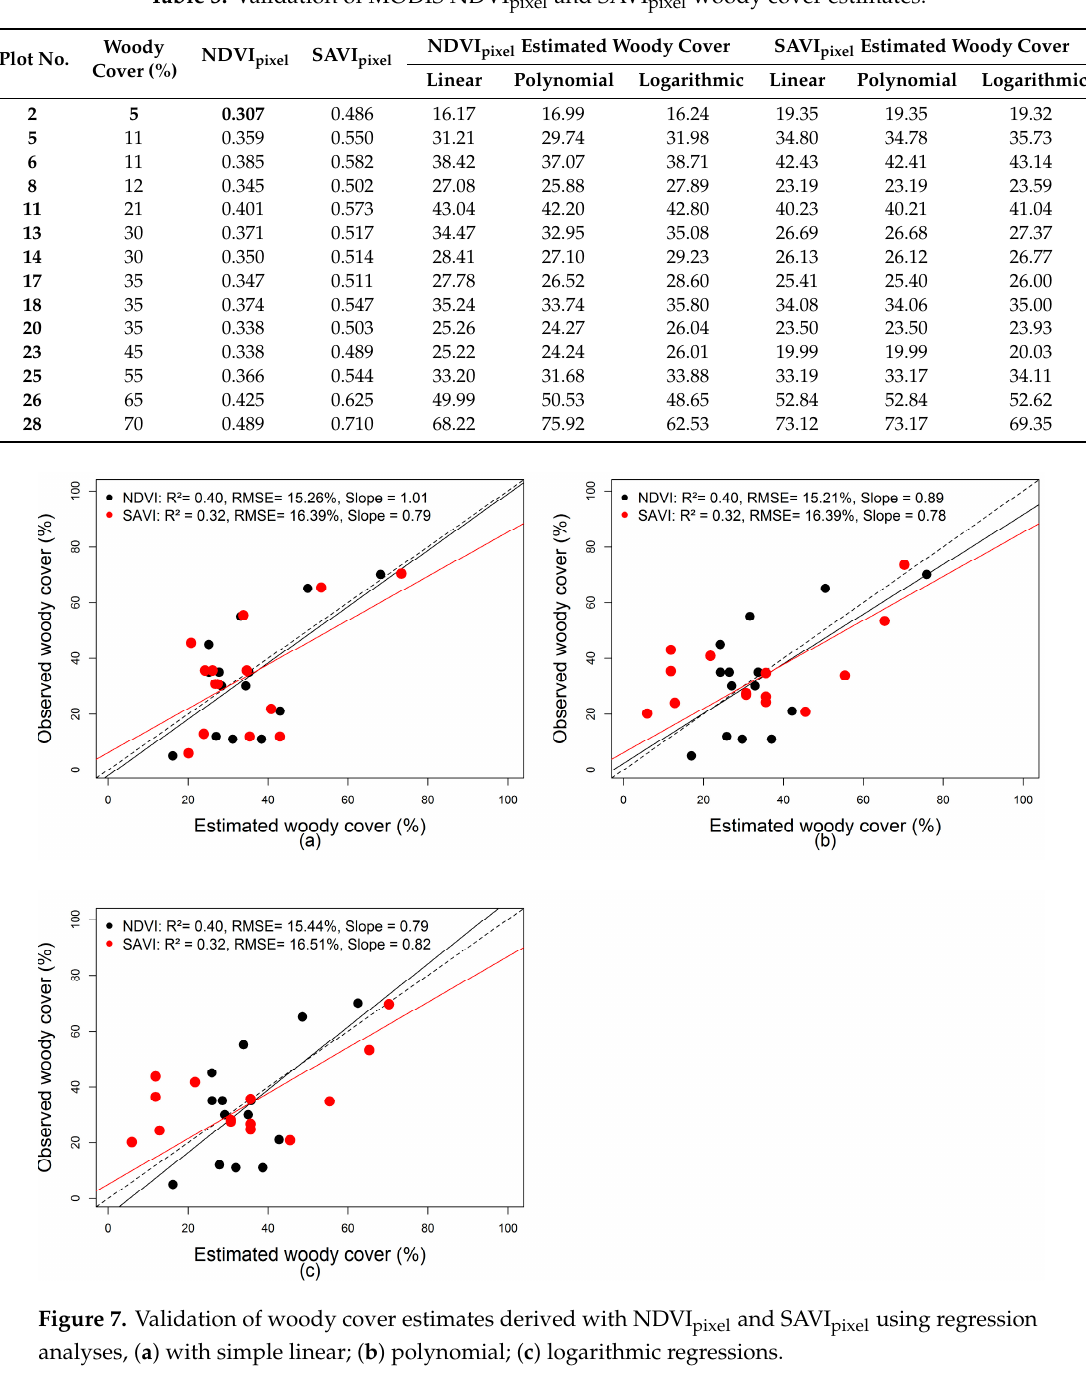
Table 3. Validation of MODIS NDVI pixel and SAVI pixel woody cover estimates. Plot No.